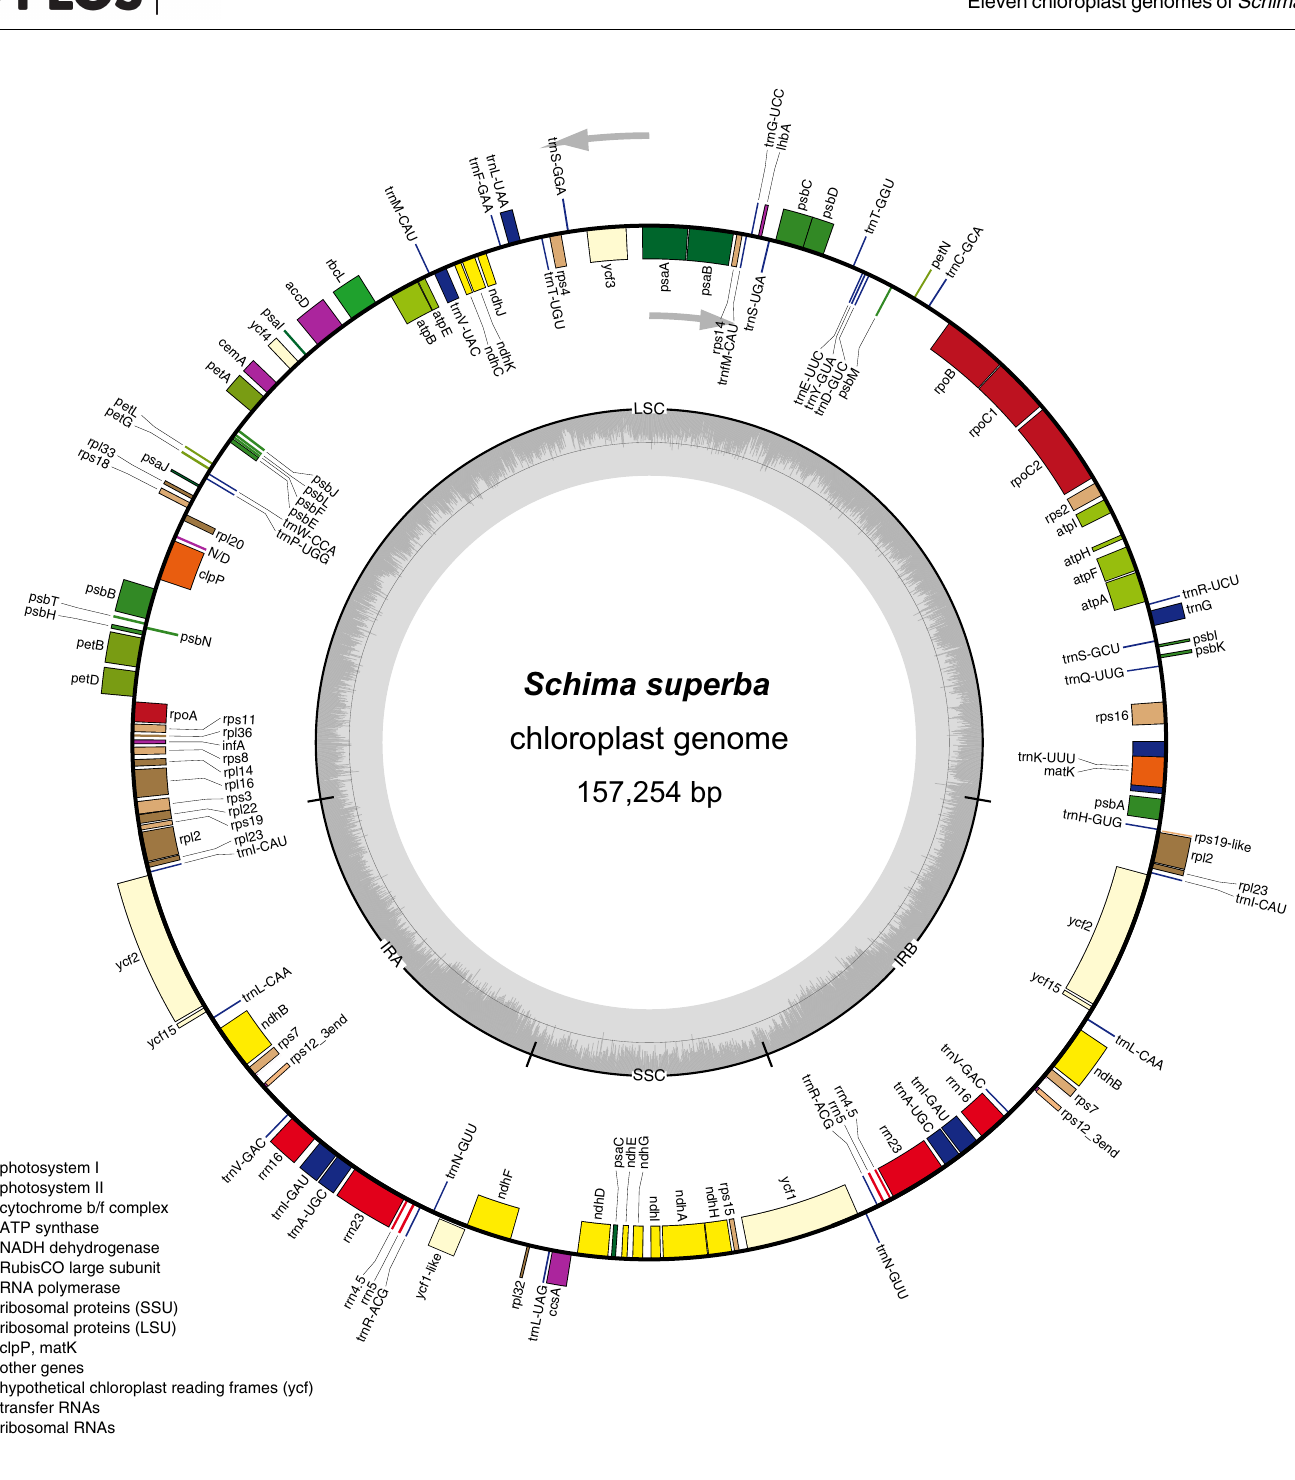
Fig 1. Gene map of Schima superba chloroplast genome. https://doi.org/10.1371/journal.pone.0178026.g001 genes had a percentage of variation above 1.00% (Table 2), while 19 ( > 150 bp) had no varia- tion. Both of the two core DNA barcodes ( rbcL and matK ) [38] showed extremely low sequence divergence (0.21% and 0.33%, respectively). Furthermore, the variation of ycf1 , the